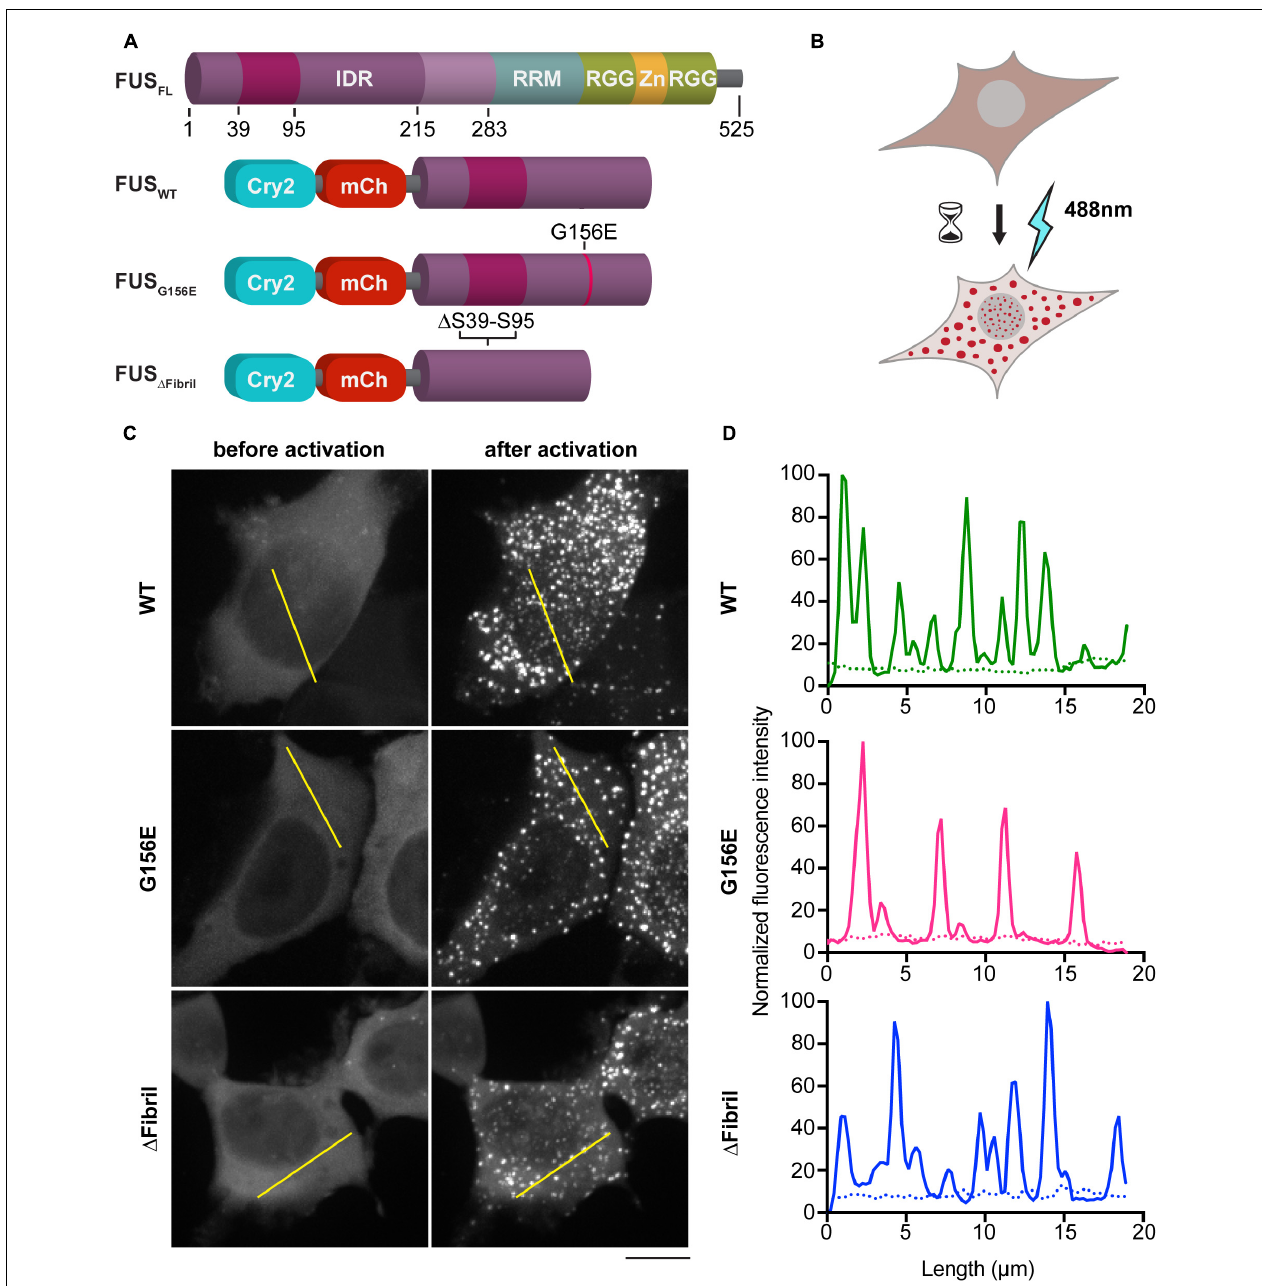
FIGURE 1 | Photoactivation of FUS condensation. (A) Scheme of full-length FUS protein (top) and chimeric constructs used in this study (bottom) (IDR, intrinsically disordered region; RRM and RGG, RNA-binding motives; Zn, Zn-finger). (B) Cartoon of the imaging assay in HEK cells. (C) Representative images (z-projections) before (left) and after (right) photoactivation of 1 min at 0.02 mW 488 nm-laser power at the output. Scale bar, 10 µ m. (D) Line profiles of highlighted regions in (C) (dotted line, before activation; full line, after